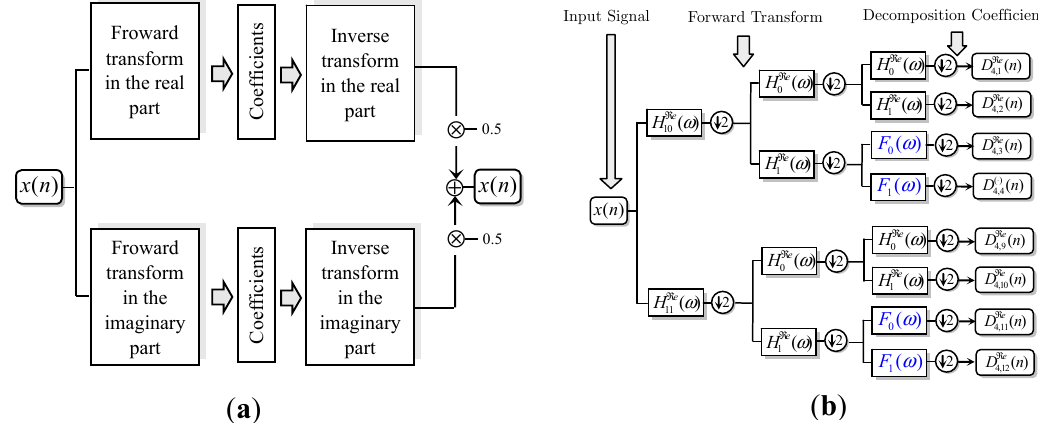
Figure 6. ( a ) The structure of the dual tree complex wavelet packet decomposition; and ( b ) the filterbank structure of a traditional WPT.